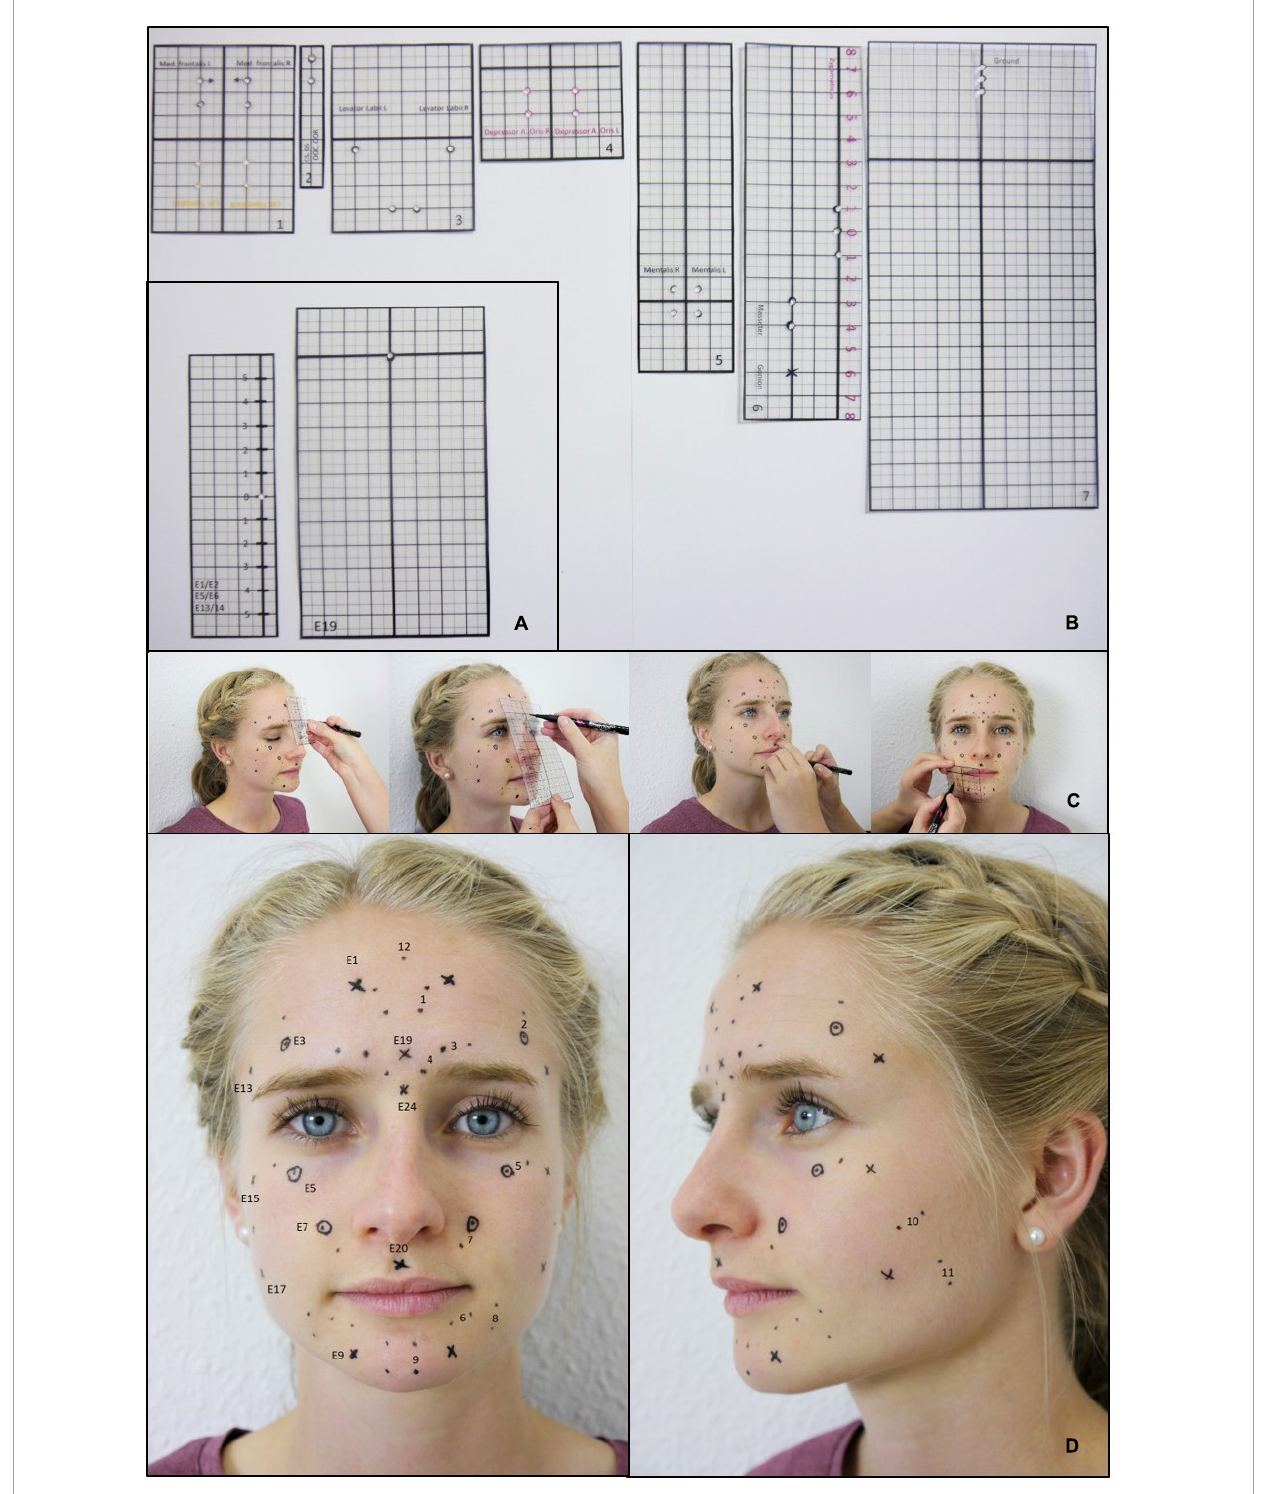
FIGURE2 Standardized application of the EMG electrodes. (A) Templates for marking the electrode positions for the Kuramoto scheme. (B) Templates for marking the electrode positions for the Fridlund scheme. (C) Example for the process of marking the electrode positions. (D) Final result: Plot of all electrode positions for both, the Fridlund and the Kuramoto scheme. Labeled positions on the left side: Fridlund scheme (always positioned between the respective electrode pair). 1 = M. frontalis medial part, 2 = M. frontalis lateral part, 3 = M. corrugator supercilii, 4 = M. depressor supercilii, 5 = M. orbicularis oculi, 6 = M. orbicularis oris, 7 = M. levator labii superioris, 8 = M. depressor anguli oris, 9 = M. mentalis, 10 = M. zygomaticus major, 11 = M. masseter, 12 = Ground; right-sided positions: Kuramoto scheme: E1 = mid-frontal region, E3 = middle of eyebrow (= M frontalis lateralis like Fridlund), E5 = infrapalpebral sulcus (M. orbicularis oculi like Fridlund), E7 = nasolabial fold (M. levator labii superioris like Fridlund), E9 = M. mentalis, E13 = M. temporalis, E15 = cheek bone, E17 = hollow, E19 = glabella, E20 = philtrum, E24 = bridge of nose (left-sided positions are always labeled left +